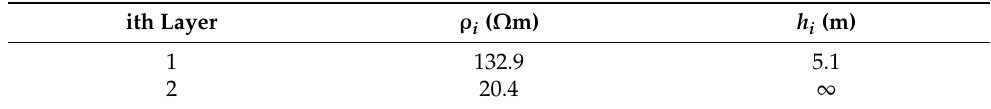
Table 2. Parameters of the two-layer structure.